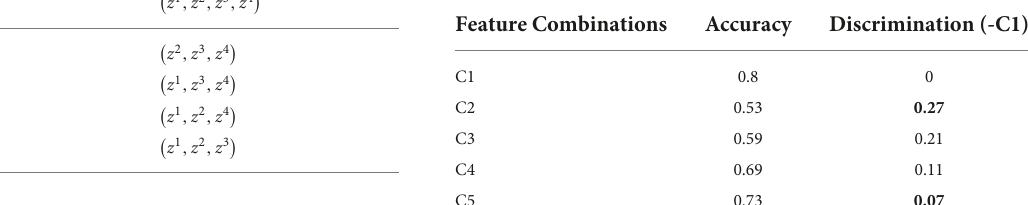
TABLE 6 Classification results with different feature combinations for Exercise A. Feature Combinations